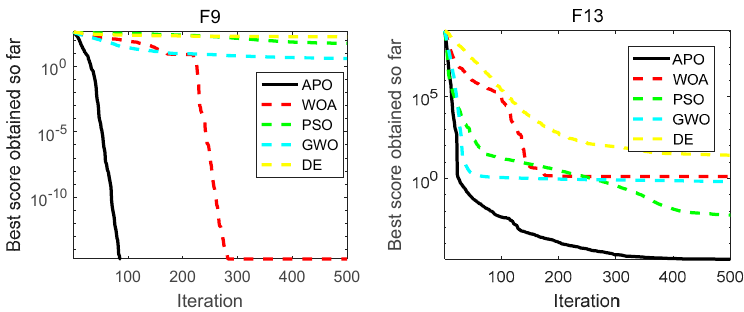
Figure 4. Evolution curves of the fitness value for some of the functions in Table 2.